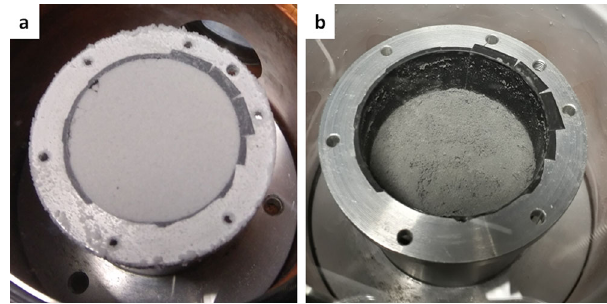
Fig. 3 The experimental sample seen through the sapphire window. a The container fi lled with the mixture of ice and Ceres analogue material at the start of the sublimation experiment. b The same container with the sublimation residue after 133 h under high vacuum at 173 K.